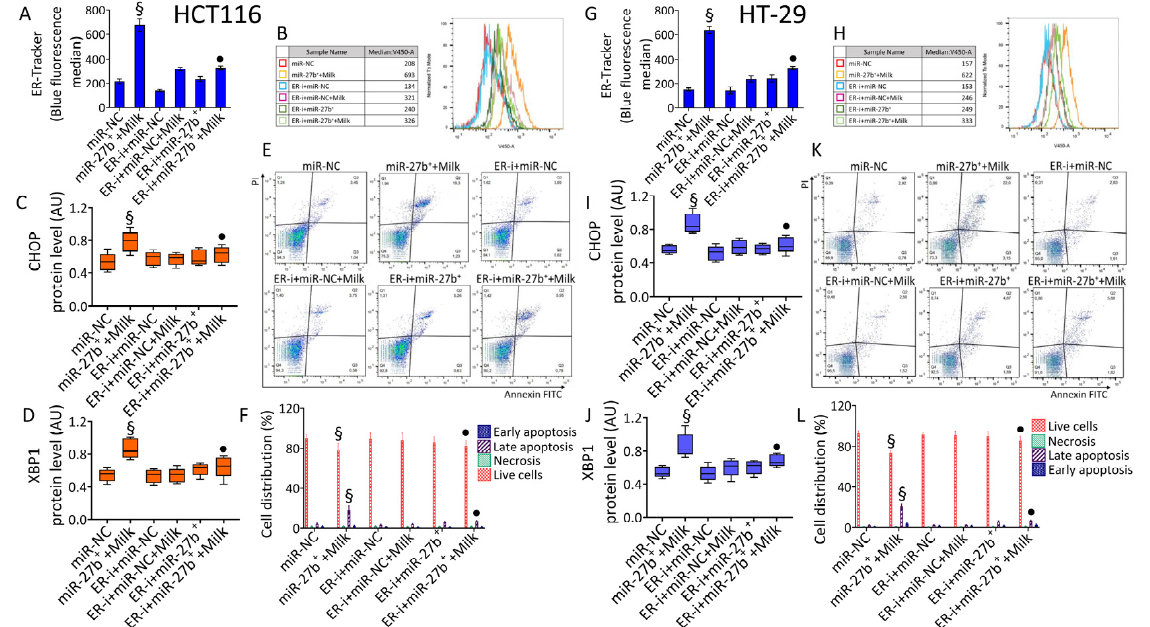
Figure 8. ER-i blocked the apoptotic effect of miR-27b + +Milk. Representative FACS analysis of ER-tracker dye, expressed as blue fluorescence median, immunoblotting analysis of CHOP and XBP1, and dot plots and analyses of annexin V-FITC and propidium iodide (PI)-staining in ( A – F ) HCT116 and ( G – L ) HT-29 cells transfected with 30 nM mimic Negative Control (miR-NC) and miR-27b mimic before 72 h with 40% v / v milk treatment (miR-27b + + Milk) or incubated for 1 h with 2 µM GSK2606414 (ER-i) and then transfected with miR-NC (ER-i + miR-NC) or with miR-27b + (ER-i+miR- 27b + ) before milk incubation (ER-i+miR-NC+Milk and ER-i+miR-27b + +Milk). Cell viability/death was assessed by flow cytometry acquiring at least 20,000 events. Lower left quadrant: viable cells; upper left quadrant: necrotic cells; lower right quadrant: early apoptotic cells; upper right quadrant: late apoptotic cells. Western blotting results ( n = 4) are expressed as arbitrary units (AU). § p < 0.01 vs. miR-NC; • p < 0.01 vs. miR-27b + +Milk.